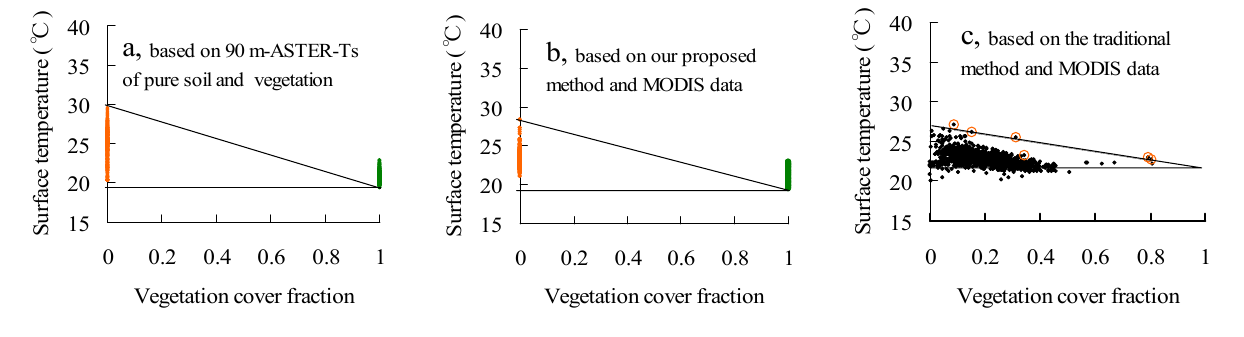
Figure 7. The VI-Ts diagrams on May 9 2003 (a) defined using the 90 m-ASTER-Ts of pure vegetation and soil, (b) defined by the proposed method using MODIS data, and (c) defined by the traditional method using MODIS data. In Figures 7a and 7b, yellow and green points are component Ts of soil and vegetation. In Figure 7c, yellow circles (o) are pixels for defining the dry